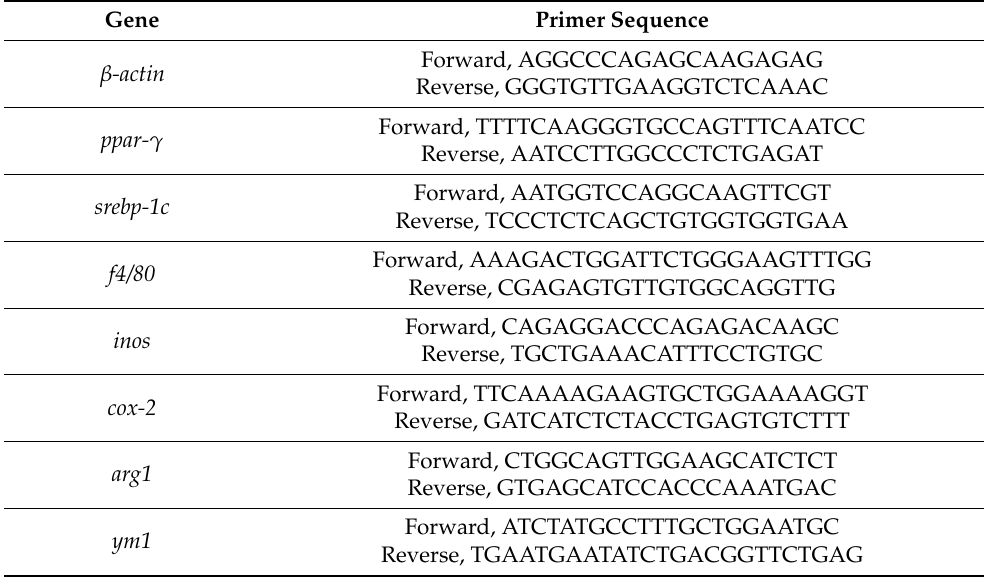
Table 2. Sequences of primers used for